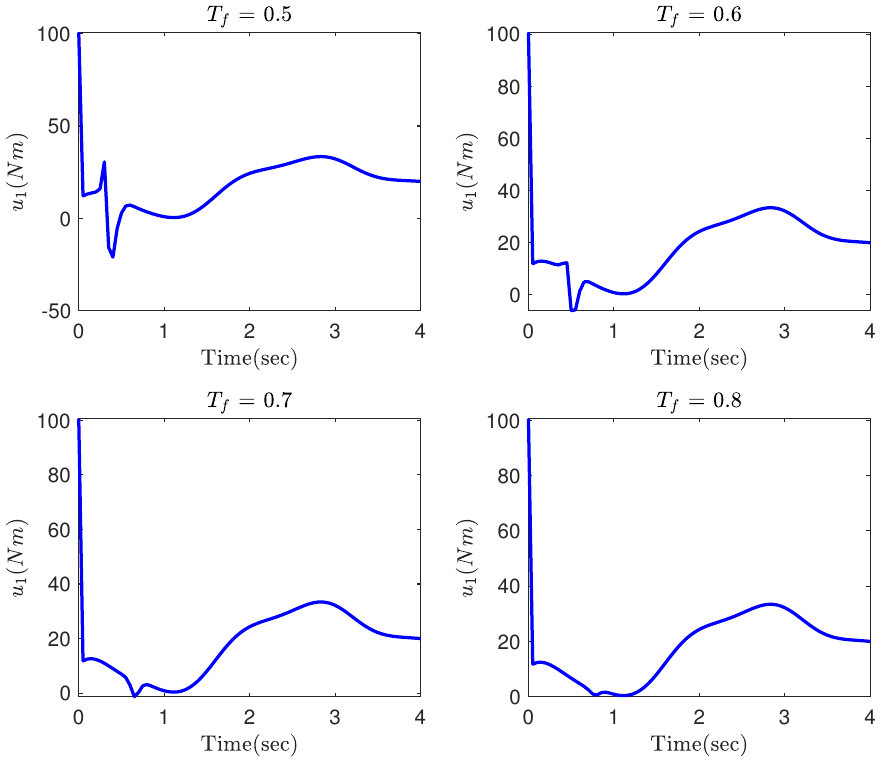
Figure 4. The first component of the control